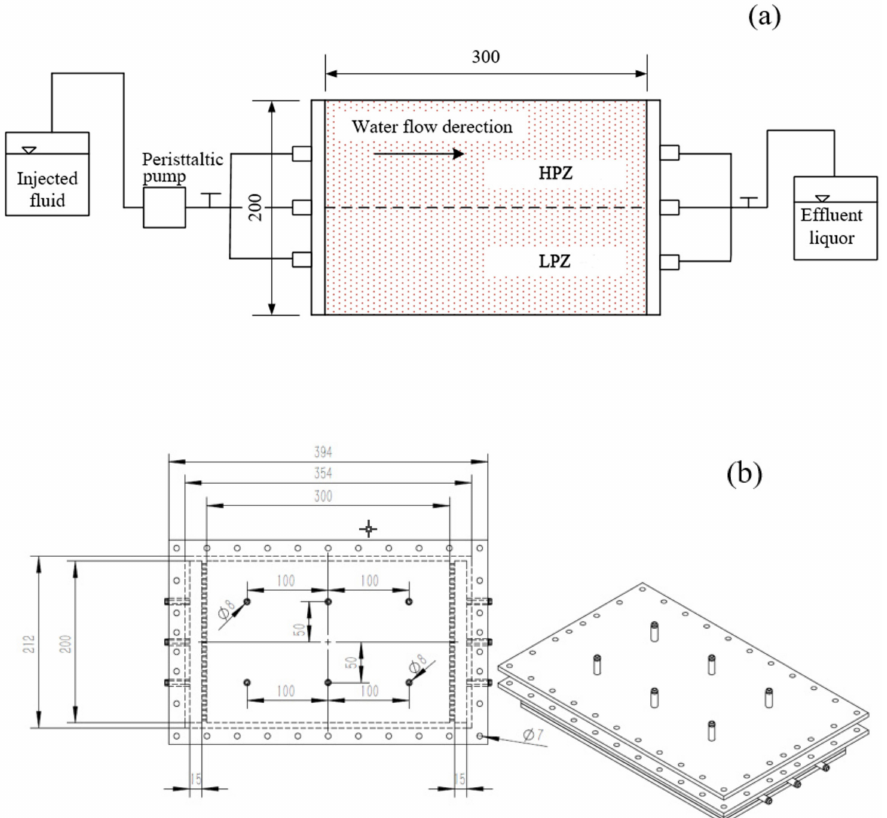
Figure 2. 2D-flow cell design. ( a ) Schematic diagram of the experimental device. ( b ) Details of the 2D-flow cell design